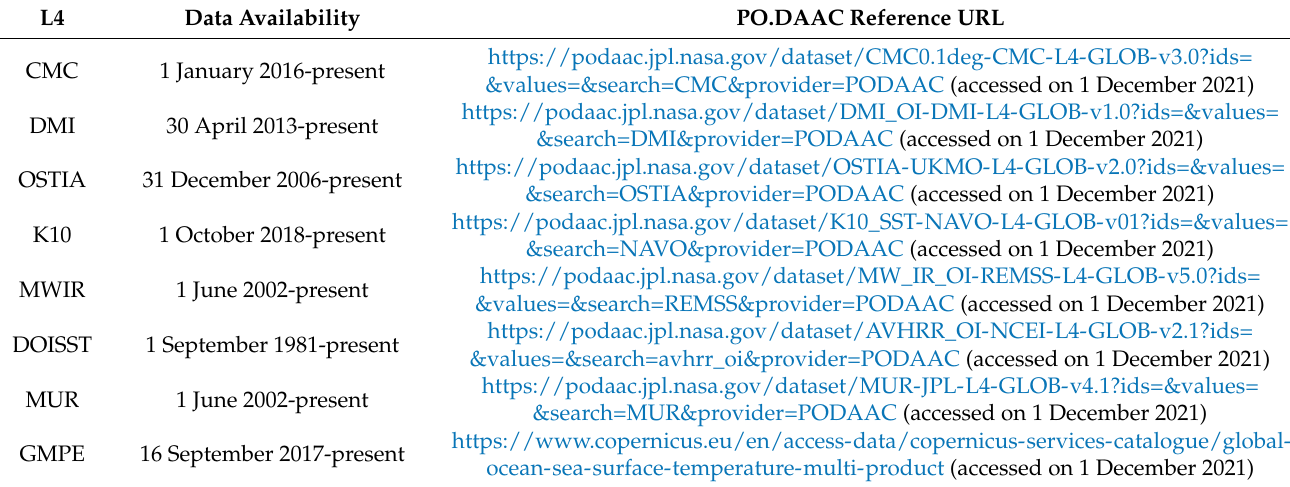
Table 1. Characteristics of GHRSST L4 data sets used in the